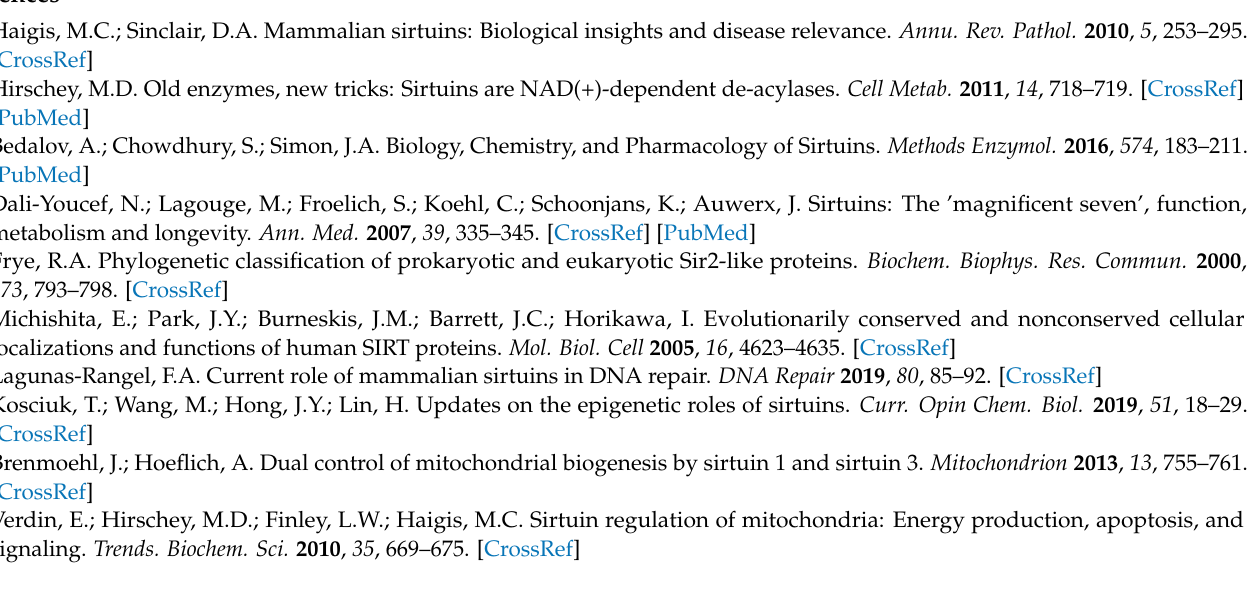
Figure S3: Probe 2A is a cell permeable SIRT1 inhibitor. Figure S4: NMR spectra of the